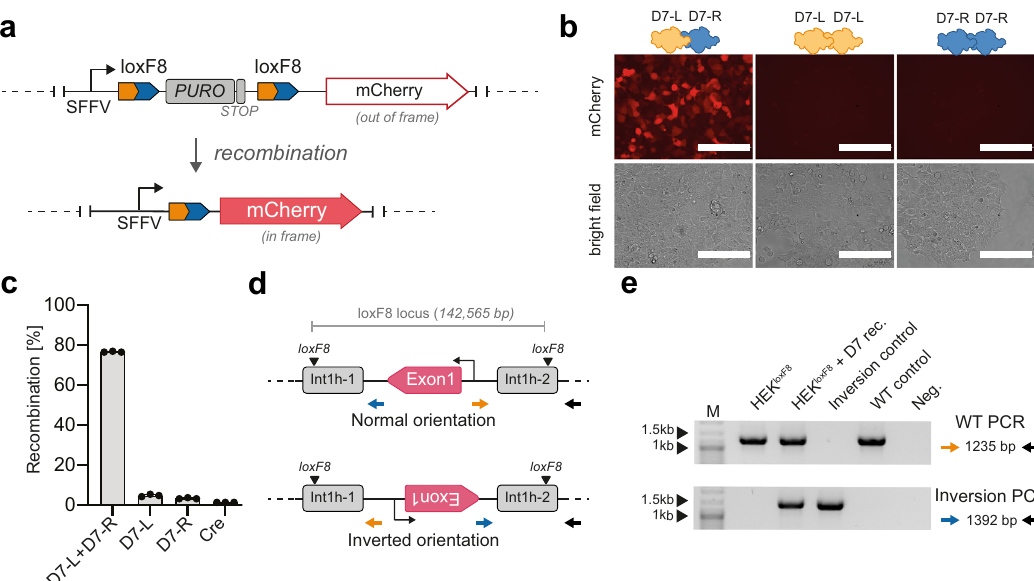
Fig. 3 Activity of the D7 heterodimer in human cells. a Schematic overview of the integrated reporter construct in HEK293T cells. Expression of mCherry is blocked by the puromycin (PURO) gene. After site-speci fi c recombination the spleen focus-forming virus (SFFV) promoter-driven puromycin resistance cassette is excised, leading to expression of the red- fl uorescent mCherry gene. b Fluorescent and bright fi eld images of transfected HEK293TloxF8 reporter cells with indicated recombinases. Note that mCherry expression is only visible in cells receiving both monomers. 200 µ m scale bars are indicated. c Quanti fi cation of recombination ef fi ciencies 48 h after transfection of HEK293T loxF8 reporter cells with indicated recombinases, analyzed by fl ow cytometry ( n = 3, biological replicates are shown as dots). Error bars represent standard deviation of the mean (SD). d Schematic overview of a fraction of the F8 gene displaying the PCR primers used to detect the orientation of the loxF8 locus. Exons are displayed in magenta and the repeated regions int1h-1 and int1h-2 are shown in gray. Primer binding sites are indicated with arrows. The position of the loxF8 target sites is indicated. The transcription start site of the F8 gene is depicted by a black arrow. e Gel image of PCR products generated using indicated primer combinations to detect the orientation of the loxF8 locus with and without treatment with the D7 heterodimer. Band sizes of the marker lane (M) are indicated. Inversion control = genomic DNA of patient-derived iPSCs carrying the exon1 inversion. WT control = genomic DNA of HEK293T loxF8 reporter cells (non-treated). Neg. = water used as template for the PCR. Source data are provided as a Source data fi